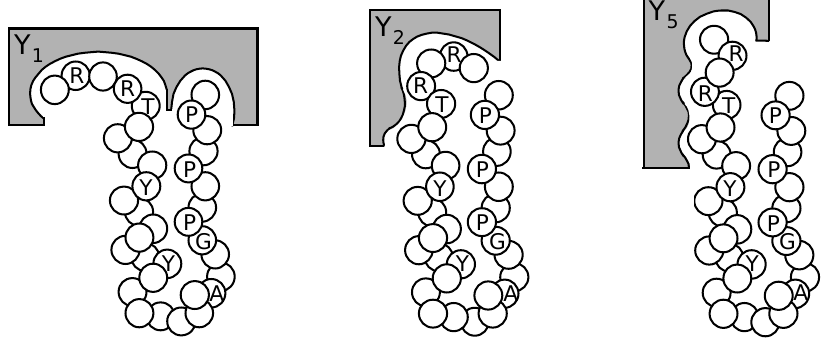
Figure 4: Scheme of different contact sites of NPY at its receptor